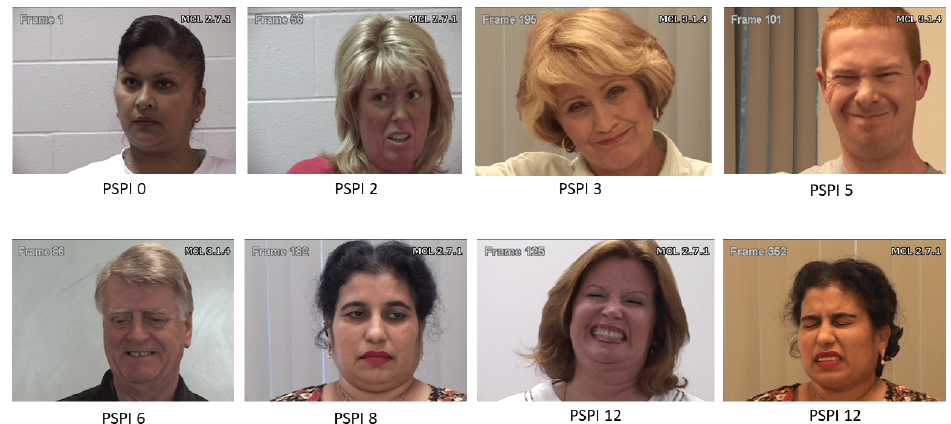
Figure 3. Sample images from UNBC McMaster dataset